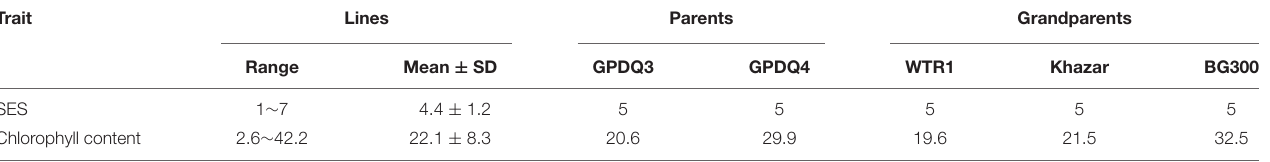
TABLE 1 | Phenotype variance of F 4 lines, parents and grandparents. Trait